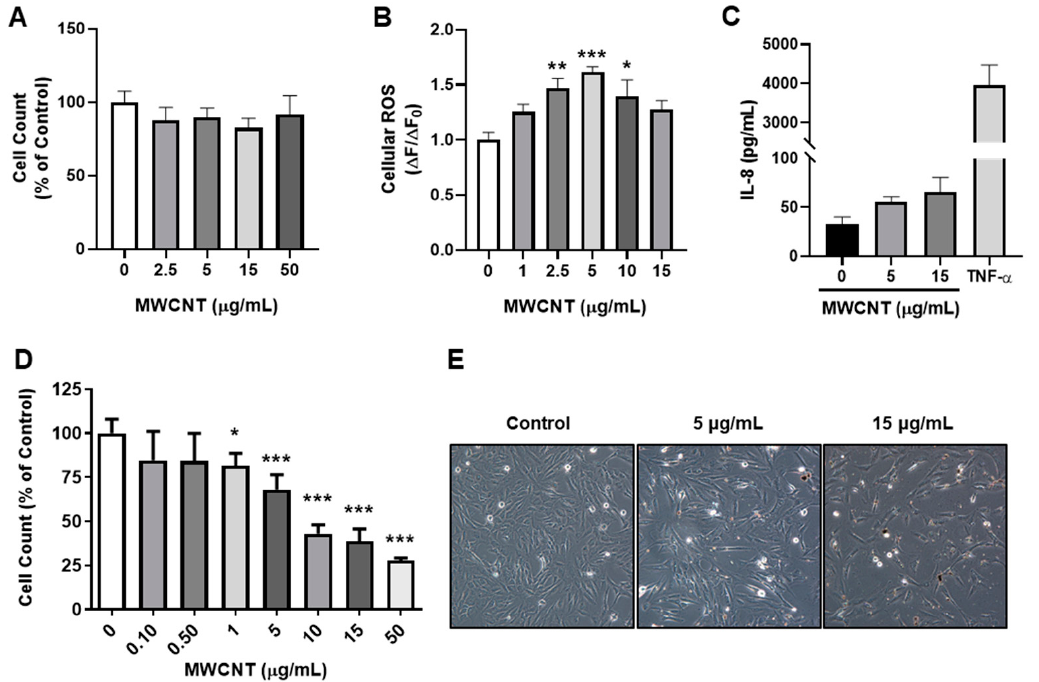
Figure 1. Cellular responses to MWCNT in BEAS2B. ( A ) Cytotoxicity was evaluated by total cell counts 24 h post exposure. Cells were rinsed and stained with AO/PI and then counted in a Cellometer 2000 ( n = 6). ( B ) Cellular ROS was determined using DCF-DA 8 h post exposure ( n = 6). ( C ) IL-8 release was assessed by ELISA in MWCNT or TNF- α (10 ng/mL) treated cells 24 h post exposure ( n = 3). ( D , E ) Cell proliferation was assessed by AO/PI staining and light microscopy 48 h post exposure. Data are expressed as mean ± SEM ( n ≥ 3). Statistical significance was determined by Tukey’s HSD (one-way ANOVA). * p < 0.05, ** p < 0.01, *** p < 0.001 indicates significance. Equal volumes of DPPC in the highest MWCNT concentration tested was added to 0 µ g/mL